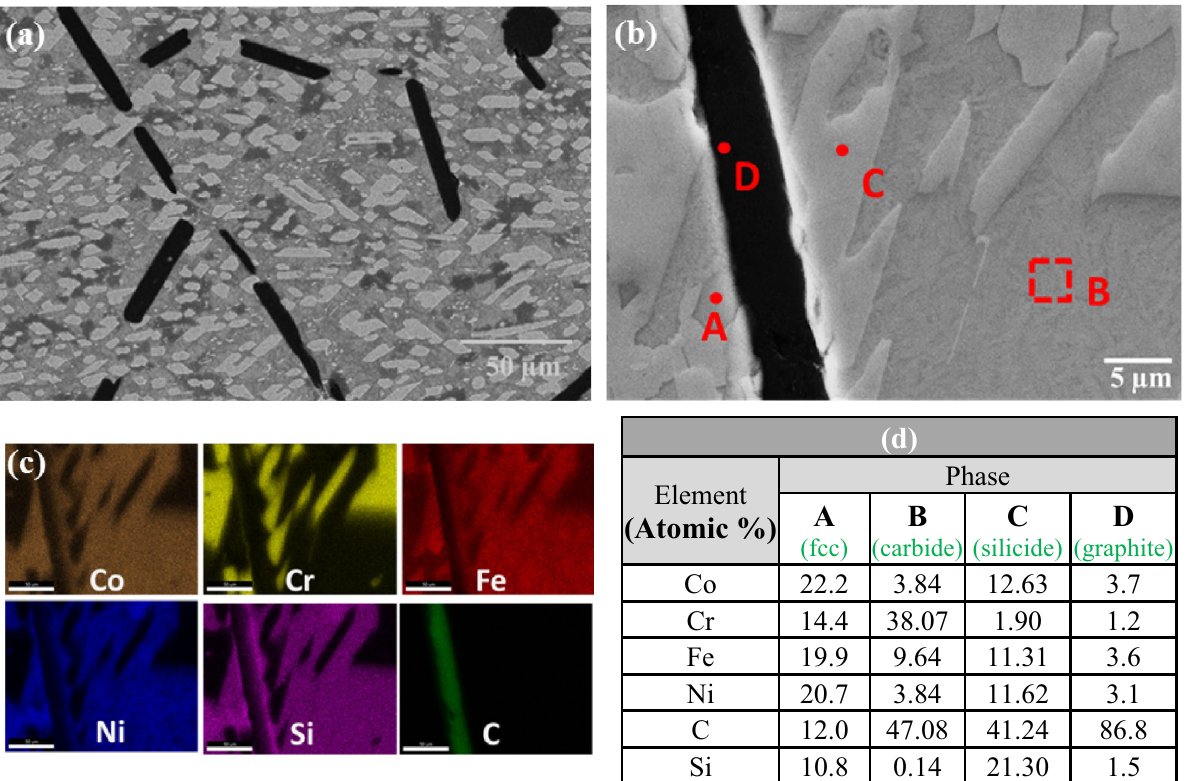
Figure 7. ( a ) SEM image of sample S-6, ( b ) magnified view, ( c ) elemental mapping, and ( d ) EDS results at the indicated positions.